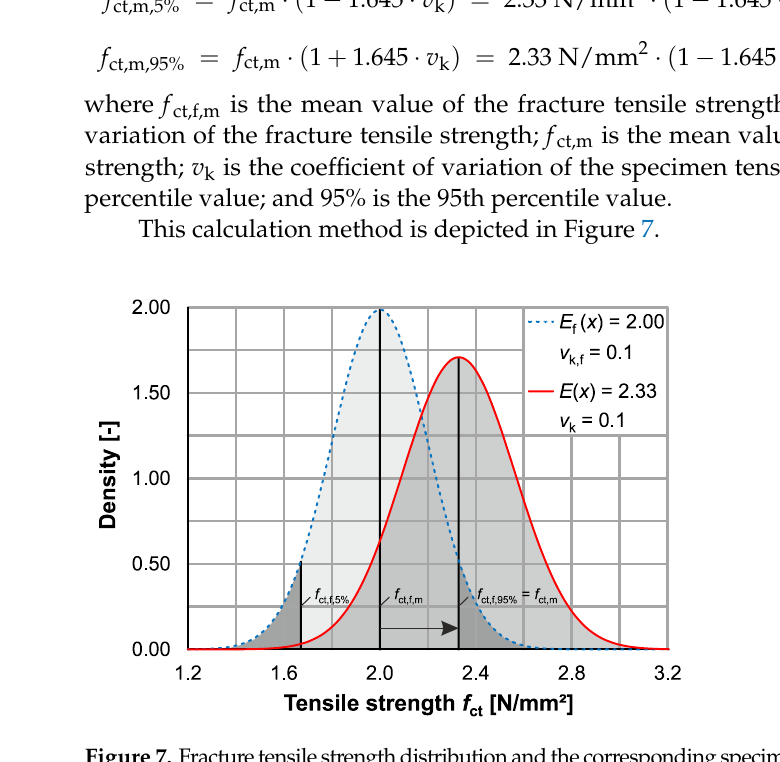
Figure 7. Fracture tensile strength distribution and the corresponding specimen tensile strength Figure 7. distribution.